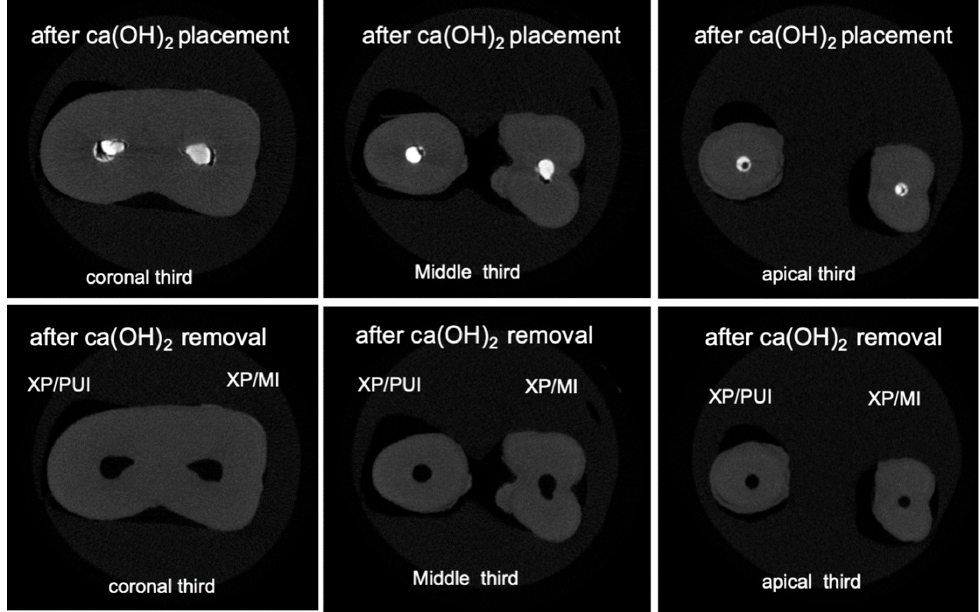
Figure 5. Cross-sectional micro-CT images of slices from coronal, middle, and apical thirds obtained before and after Ca(OH) 2 removal. Top images represent cross-sections from different levels of the root canals after the placement of Ca(OH) 2 . Bottom images represent cross-sections from different levels of the root canals after the placement of Ca(OH) 2 .